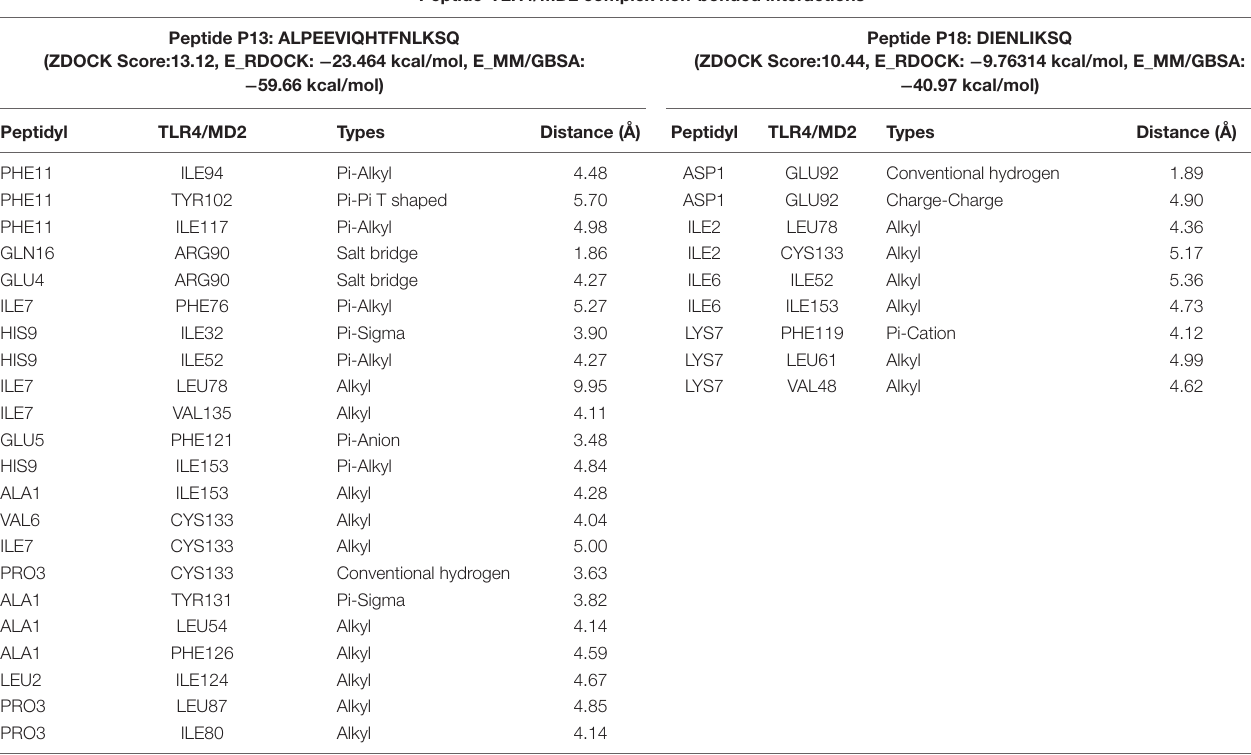
Frontiers in Molecular Biosciences |